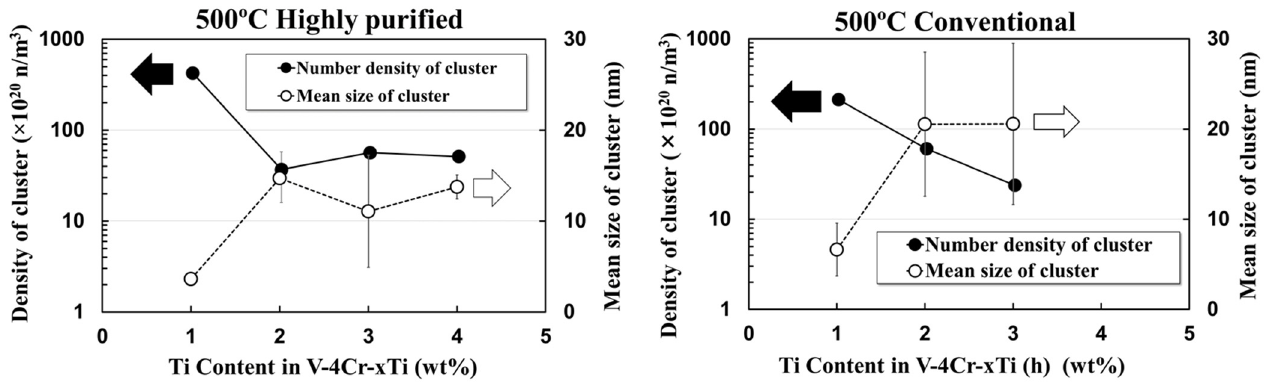
Figure 5. Number density and mean size of defect clusters in V–Cr–Ti alloys irradiated at 500 °C as a function of Ti content in V–4Cr–xTi. Left plot for V–Cr–Ti(h) alloys with highly purified impurity level and right plot for V–Cr–Ti alloys with a conventional impurity level.